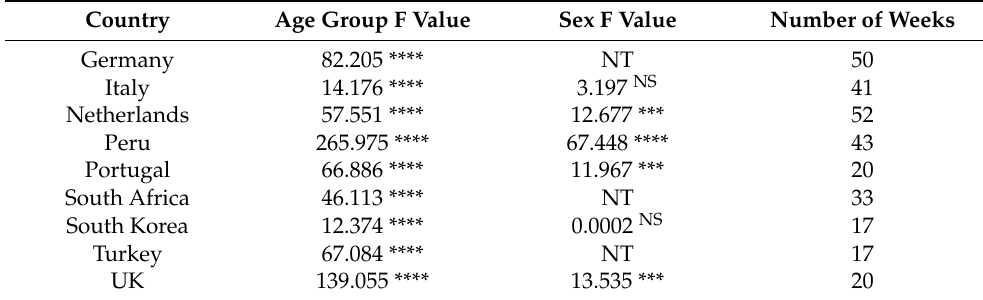
Table 4. Summary F values for variations among age groups and between the two sexes in COVID-19 case fatality rates in nine countries. Country Age Group F Value Sex F Value Number of Weeks